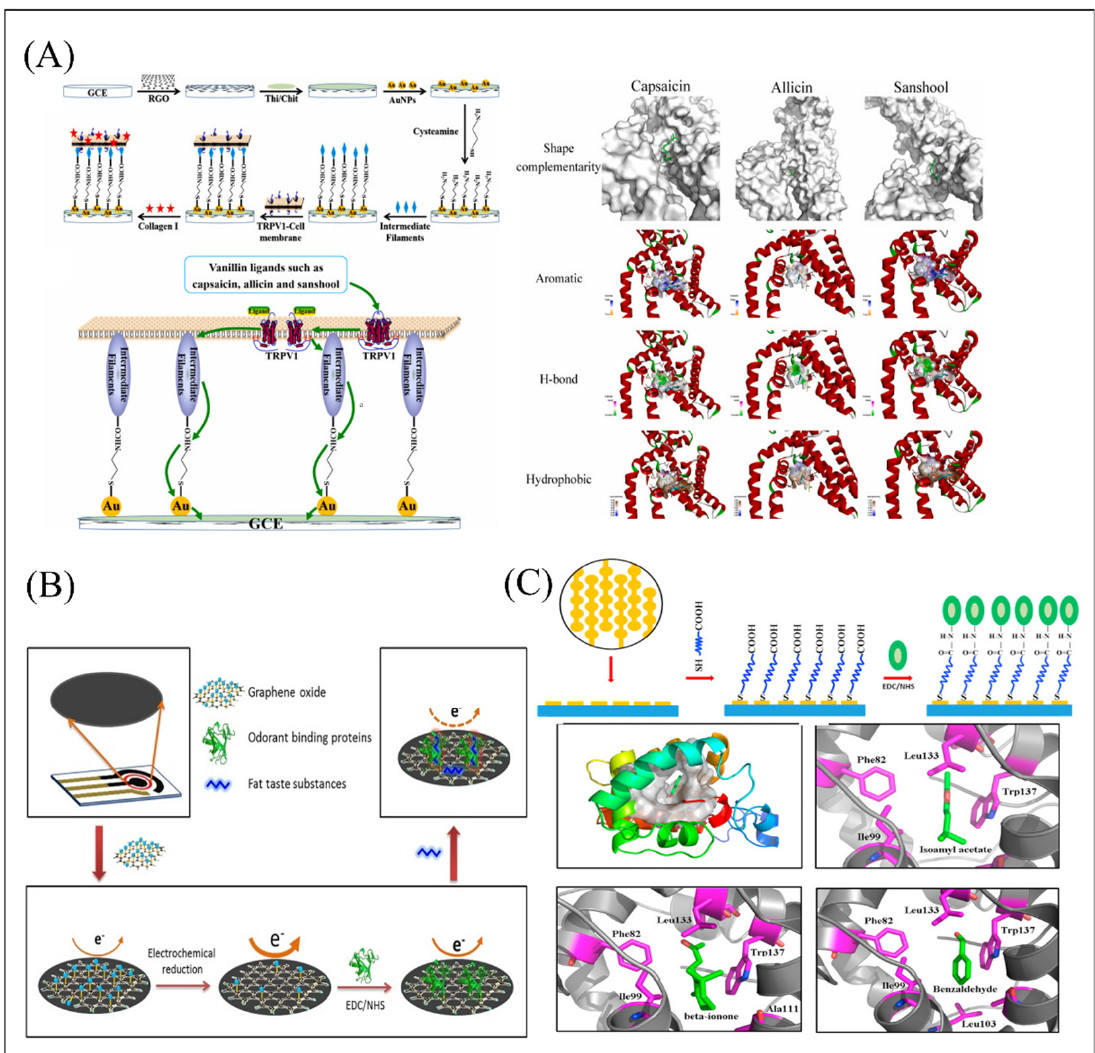
Figure 8. ( A ) Description of the preparation procedure, detection schematic diagram and molecular docking analysis of hTRPV1-cell membrane biosensor. Reproduced with permission from Ref. [67]. ( B ) Schematic diagram of the electrochemical gustatory biosensor based on screen-printed electrodes (SPE) for fat taste detection. Reproduced with permission from Ref. [115]. ( C ) Schematic of the preparation process of the interdigitated electrodes modified with PEG via Au-S bonds and functionalized with OBPs through EDC/NHS coupling and the molecular docking between BdorOBP2 and semiochemicals for affinity assessment. Reproduced with permission from Ref. [116].